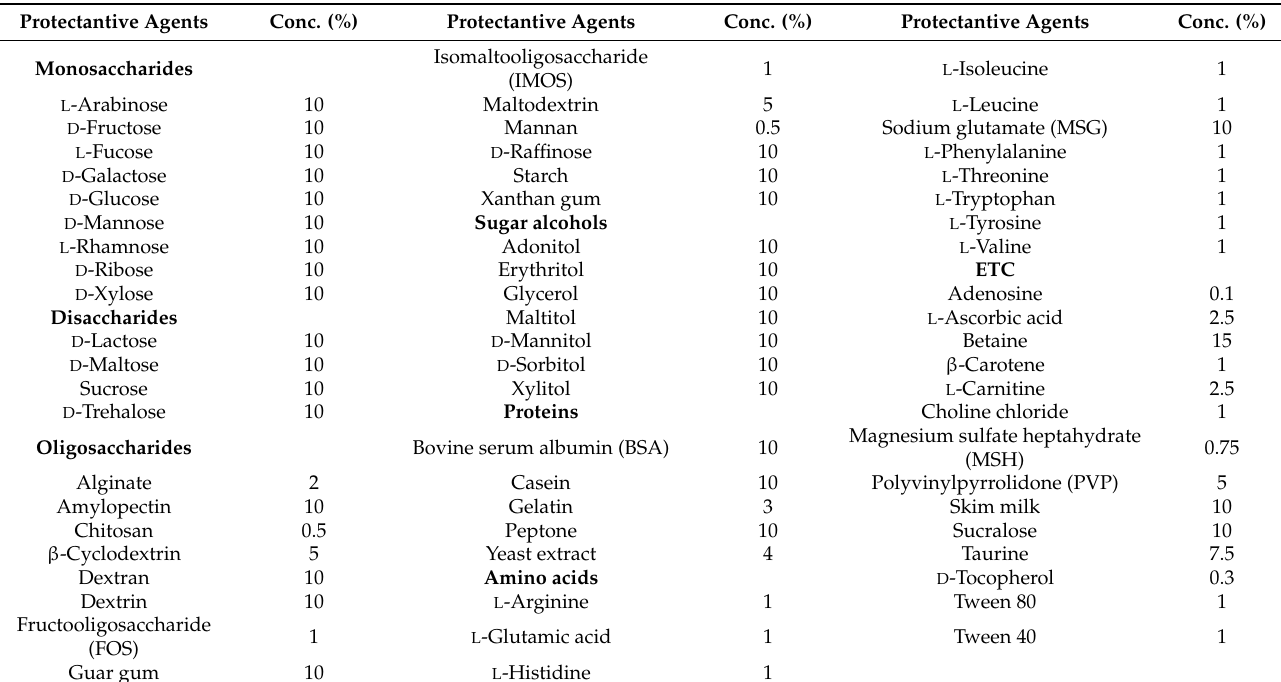
Table 1. List of protective agents and its concentration used in this